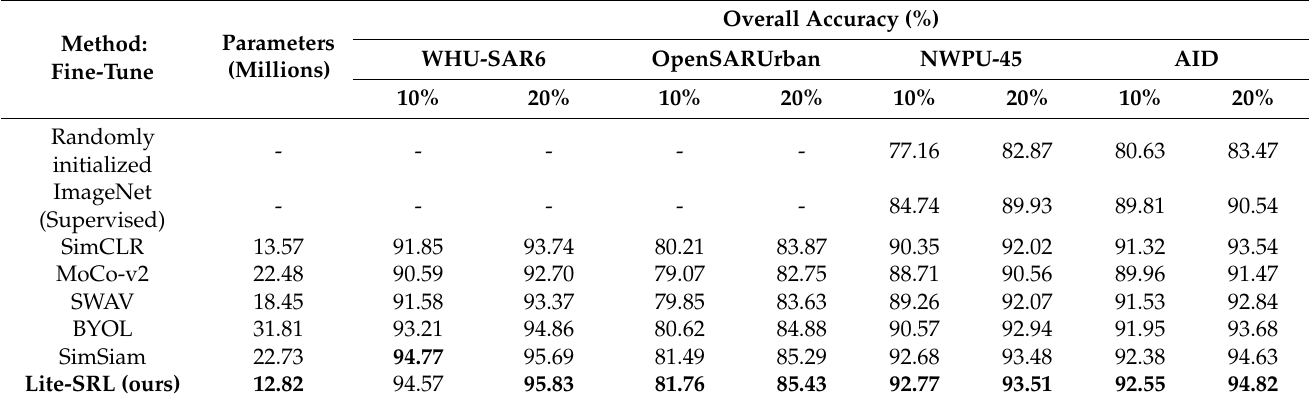
Table 3. Results of fine-tune experiment in terms of overall accuracy